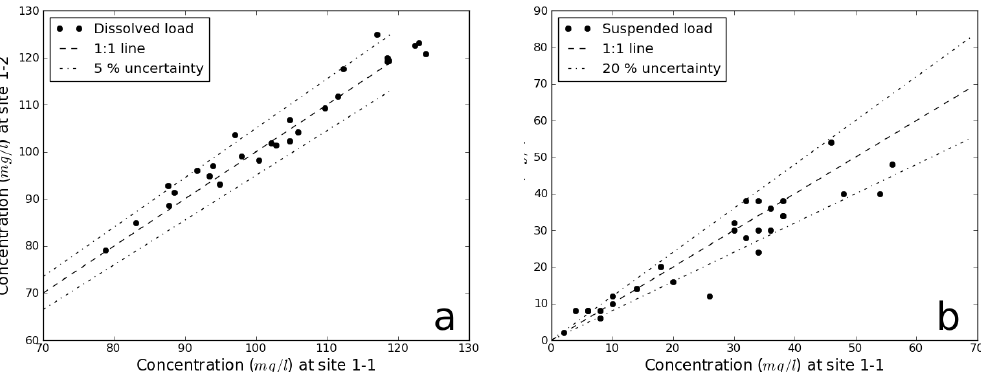
Fig. 4. Reliability of measured fluxes: (a) Comparison between measured concentrations in major ions in the glacial valley at sites 1-1 and 1-2. (b) Comparison between measured suspended concentrations at both subsites. The dashed line represent perfect agreement, and the dotted-dashed lines represent 5% deviation from 1:1 agreement for the dissolved load and 20% deviation for the suspended load.